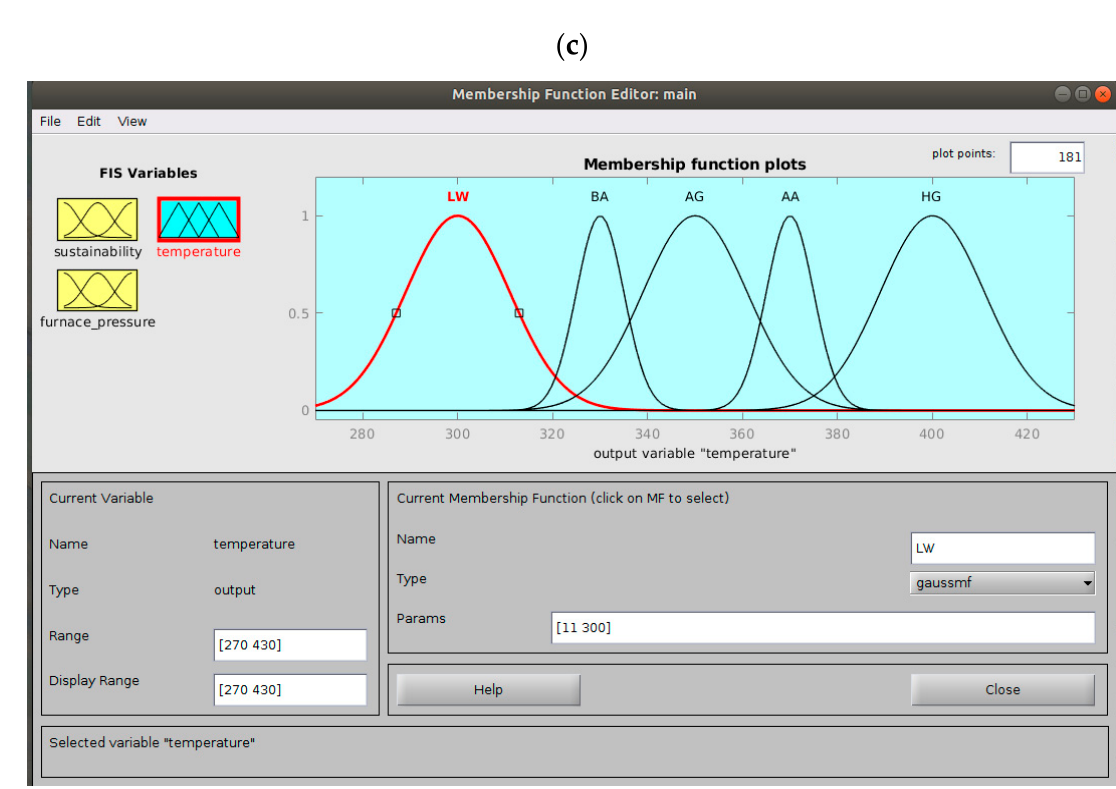
Figure 4. Membership functions of fuzzy input parameters ( a ) sustainability, ( b ) furnace_pressure and fuzzy output parameter, ( c ) temperature of the hydrotreating process.